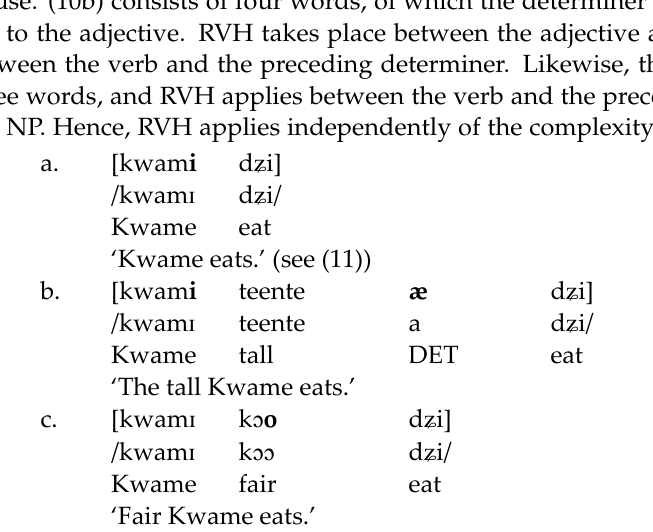
Figure 1. ( a ) Waveform, spectrogram of the noun k ɔ t ʊ ‘hat’; ( b ) Waveform, spectrogram of the NP